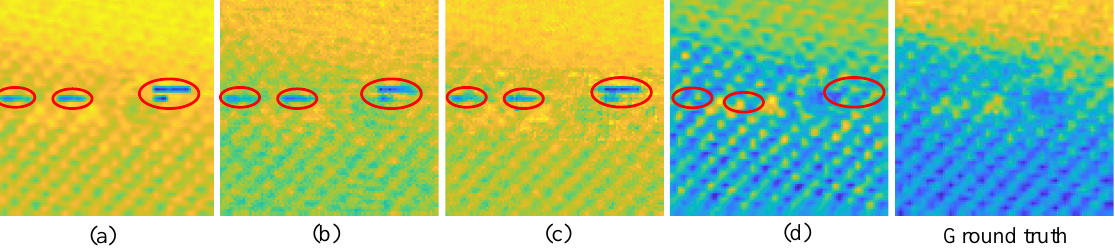
Figure 10. Average SSIM between the reconstruction results of different methods and the ground truth on all specimens.